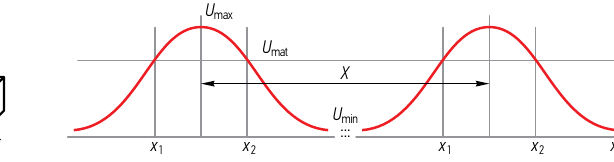
Fig. 1. Block diagram of measurement system